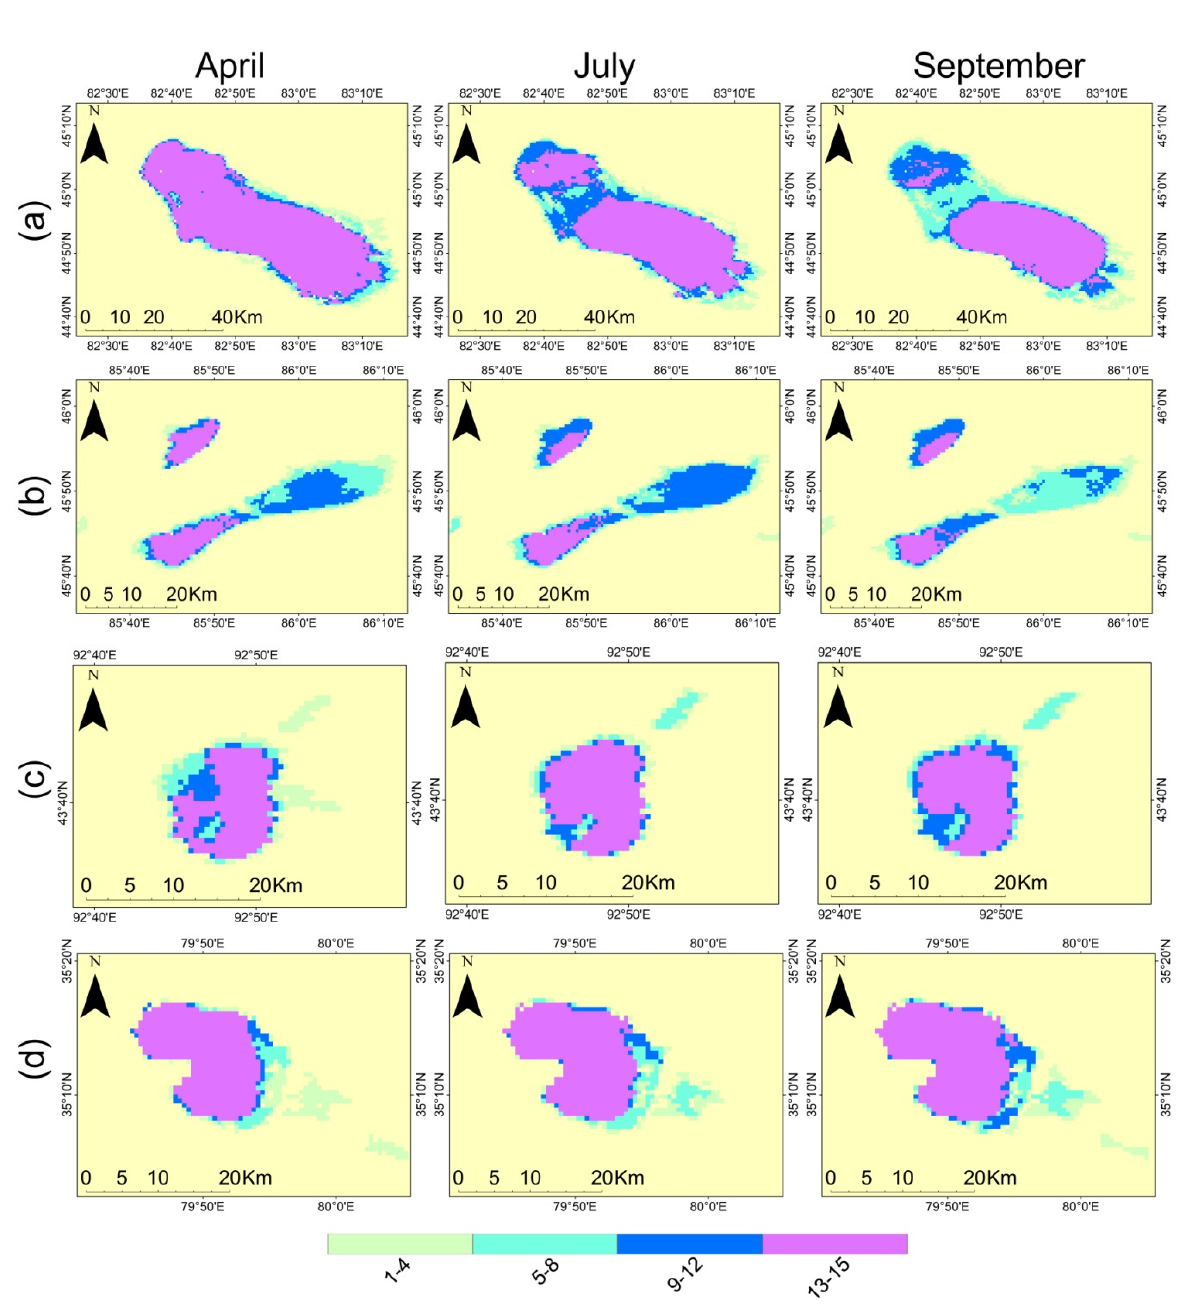
Figure 7. Typical seasonal water bodies of XUAR and their temporal dynamics for the months of April, July, and September from 2000 to 2014. ( a ) Ebinur; ( b ) Manas; ( c ) Barkol and ( d ) Aksayquin Lakes. The numbers at each pixel indicate the number of times it was detected as a water body during the 2000–2014